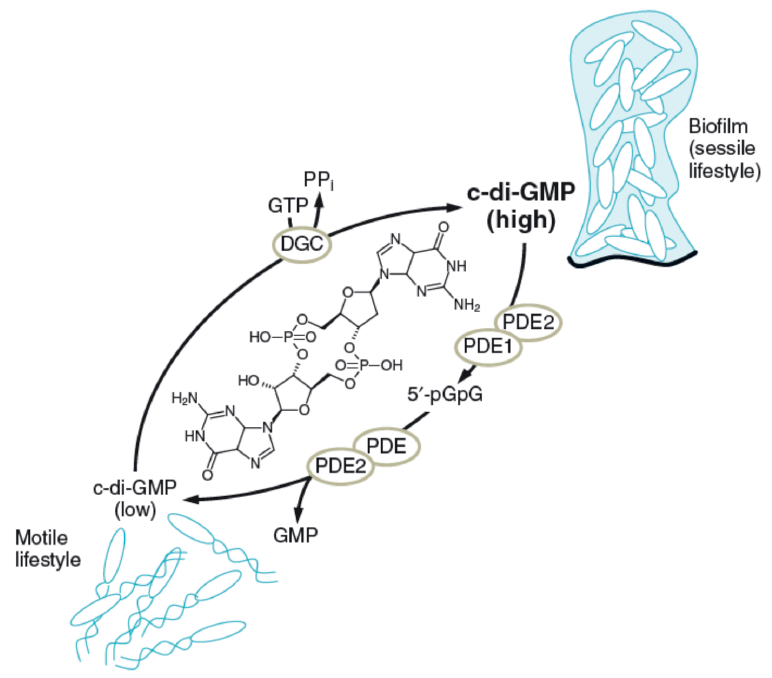
Figure 5. Control of biofilm formation by c-di-Guanidinemonophosphate (c-di-GMP). Concentration of c-di-GMP is regulated by DGC (Diguanylate cyclase; GGDEF domain: diguanylate cyclase), PDE 1 (Phosphodiesterase; EAL domain: diguanylate phosphodiesterase, linearizes c-di-GMP to 5 ′ -pGpG), PDE (nonspecific cellular PDEs, further degrading 5 ′ -pGpG to GMP), and PDE 2 (Phosphodiesterase; HD-GYP domain, metal dependent, unrelated to the EAL domain, linearizes c-di-GMP to 5 ′ -pGpG, degrades 5 ′ -pGpG further to GMP). pGpG—5 ′ phosphoguanylyl(3 ′ ,5 ′ )guanosine; GMP—Guanosine-